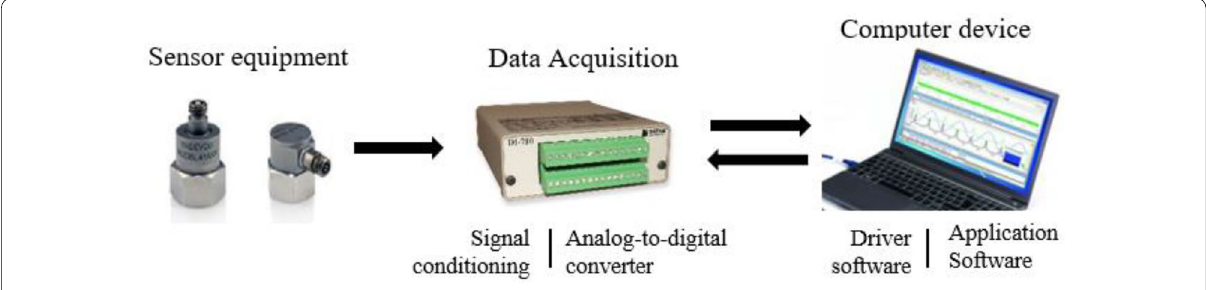
Fig. 4 Ambient vibration test system